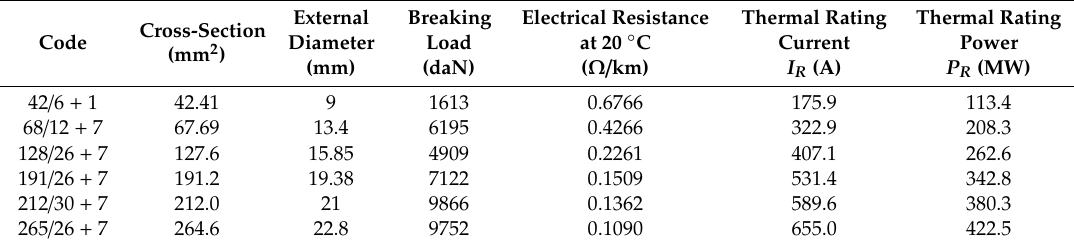
Table 10. Potentially replaceable standard ACSR